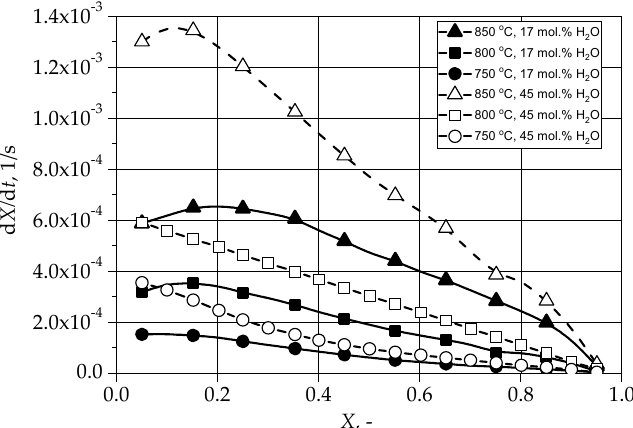
Figure 4. Reactivity of RPC char under different temperatures (750, 800 and 850 °C) and steam mole fractions (0.17 and 0.45) for the VM.